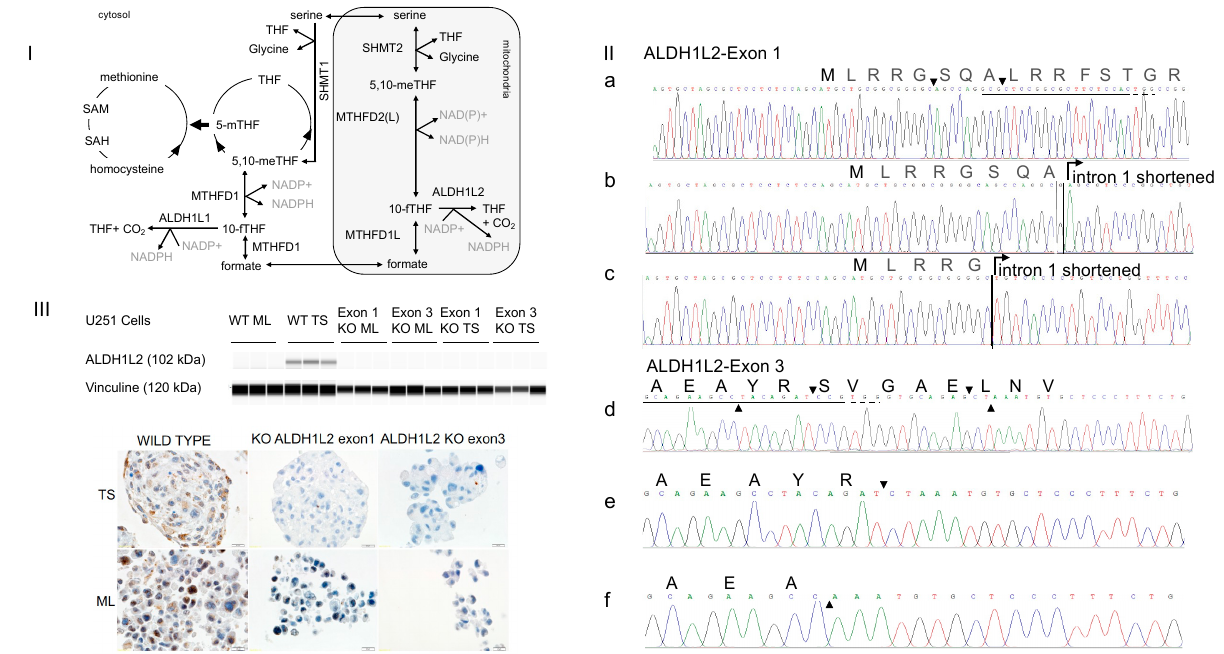
Figure 1. ALDH1L2 KO U251 glioblastoma cells were generated using the CRISPER-Cas9 system ( I ) One carbon metabolism features linked mitochondrial and cytosolic pathways; folate and méthionine cycles are intertwinned in the cytosol. THF: TetraHydroFolate, 5,10-meTHF: 5,10 methylene THF, 10-fTHF: 10-formylTHF, 5-mTHF: 5 methyl THF, SAM: S-adenosyl methionine, SAH: S-adenosyl homocysteine. ( II ) Genomic Sanger sequencing of individual deletion clones shows bi-allelic disruption of targeted exons 1 and 3. For exon 1, the new sequences diverge from the wild type sequence by deletions of 42 and 62 bp. Wild type sequence is shown in ( a ) with arrows indicating the breaking points. Sequencing of the 42 deletion including 24 bp of exon 1 and 18 bp of intron 1 is shown in ( b ) and sequencing of the 62 bp deletion including 33 bp of exon 1 and 29 bp of intron 1 in ( c ). The consequences of these deletions on protein synthesis are unpredictable since they carry away the 5 ′ end of intron 1. For exon 3, the divergence is due to deletions of 14 and 23 bp. Wild type sequence is shown in ( d ) with top and bottom arrows indicating the 14 and 23 bp deletion boundaries inside exon 3. Sequencing of the 14 and 23 deleted exon 3 is shown in ( e ) and ( f ) with arrows indicating the breaking points. Both deletions were mapped and confirmed to yield the same truncated protein with a stop codon generated at codon 113 of the newly synthesized proteins. Sequences targeted by the sgRNA are underlined in solid lines and PAM sequences in dashed line. Amino acid sequences are depicted in single letter code above nucleotide sequences. ( III ) WES TM analysis of ALDH1L2 protein in U251cells in the upper panel shows that ALDH1L2 is detected in wt TS but not in the deletion clones. It is of note that ALDH1L2 is weaky expressed in the wt ML. Immunohistolological staining of the ALDH1L2 in wt and knockout cells in the lower panel. Abbreviations, wt: Wild Type; ML: MonoLayer Cells; TS: Tumor Spheres; KO: knockout.